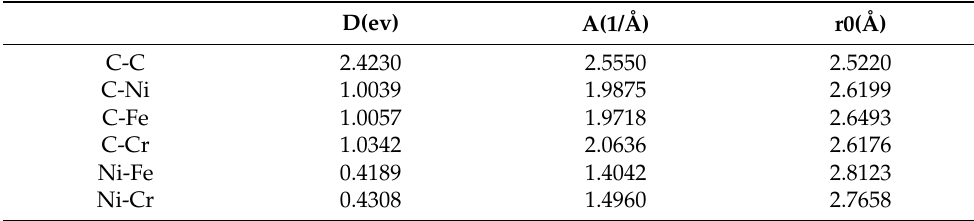
Table 2. Morse parameters between several